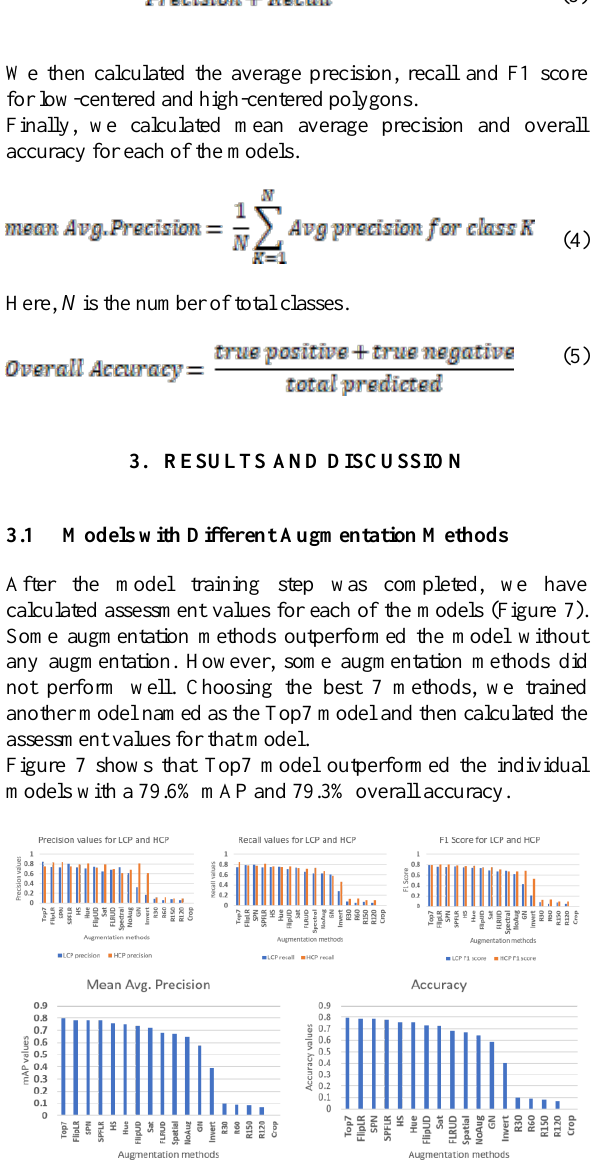
Figure 7. Performance analysis of augmentation